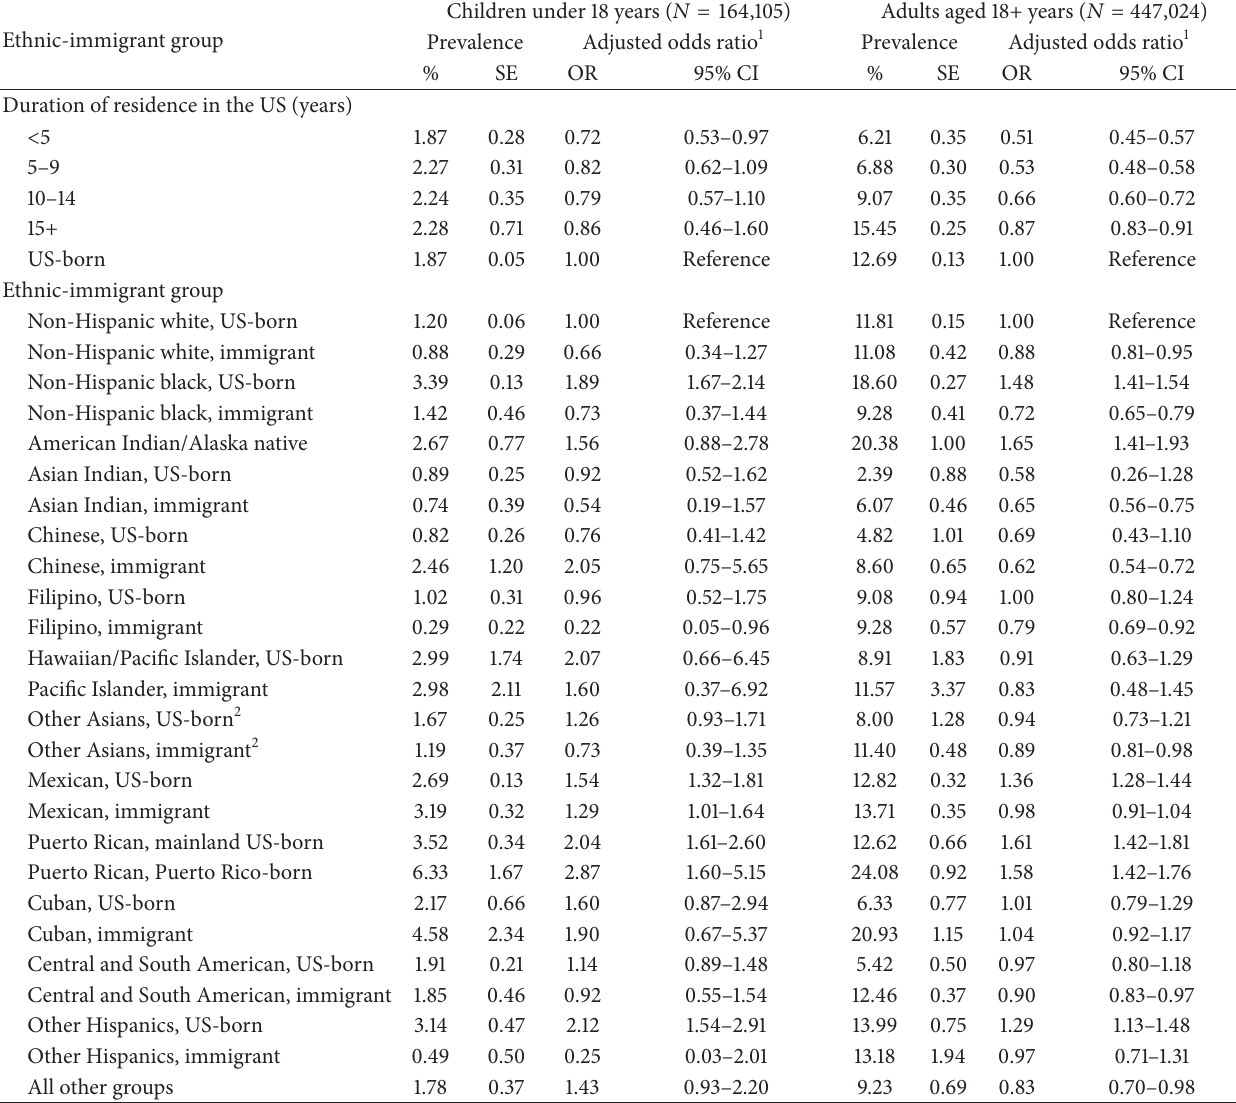
Table 5: Weighted prevalence and adjusted odds of parent- or self-assessed fair or poor health among US children and adults from 26 ethnic- immigrant groups: The National Health Interview Survey,